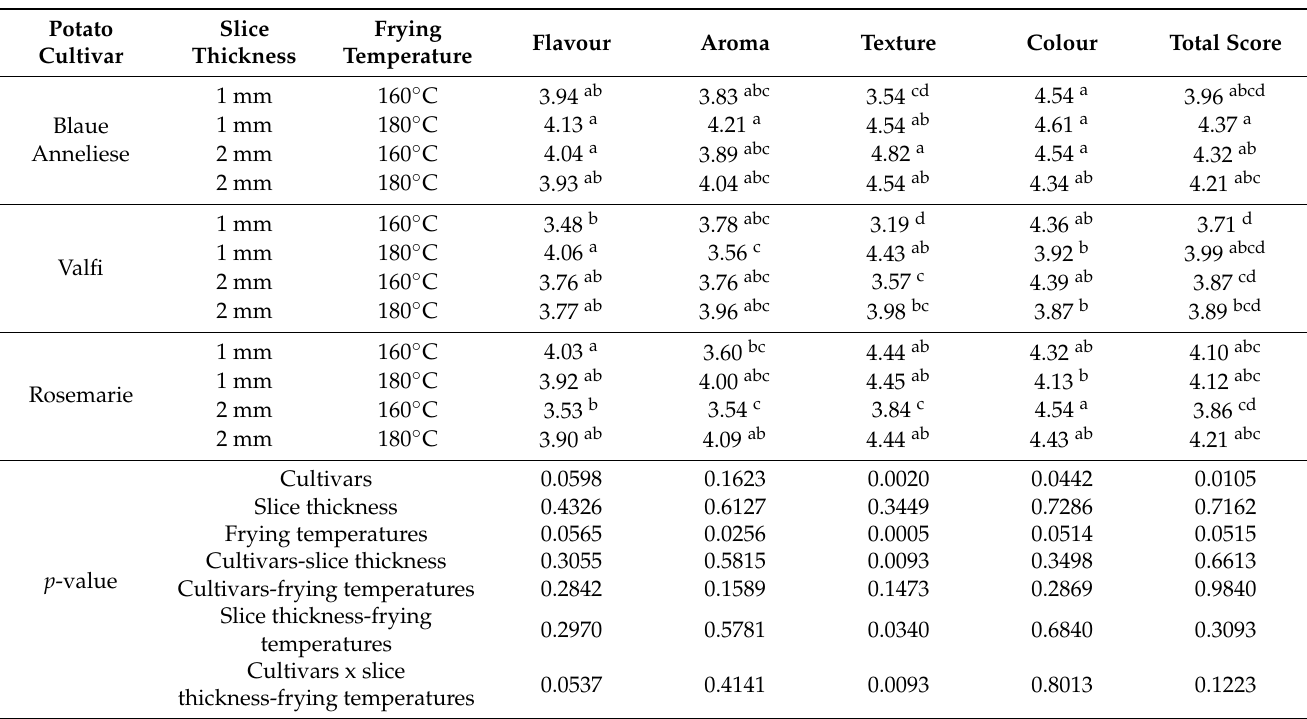
Table 5. The influence of cultivar, slice thickness and frying temperature on the sensory attributes of chips produced from coloured potato cultivars.